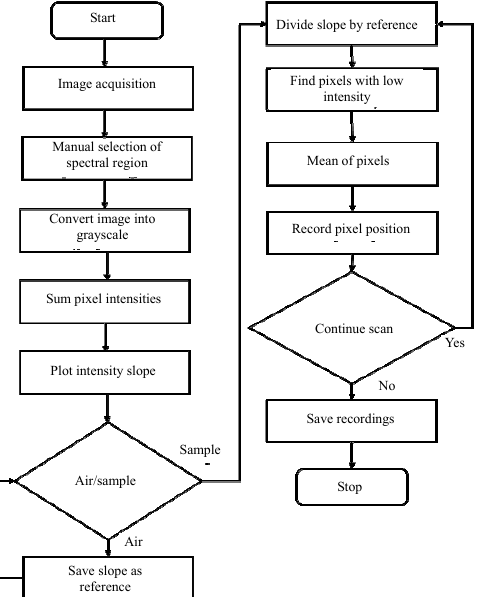
Fig. 11 Image processing involved in spectrum analysis for extraction of spectral data and finding the dip position.